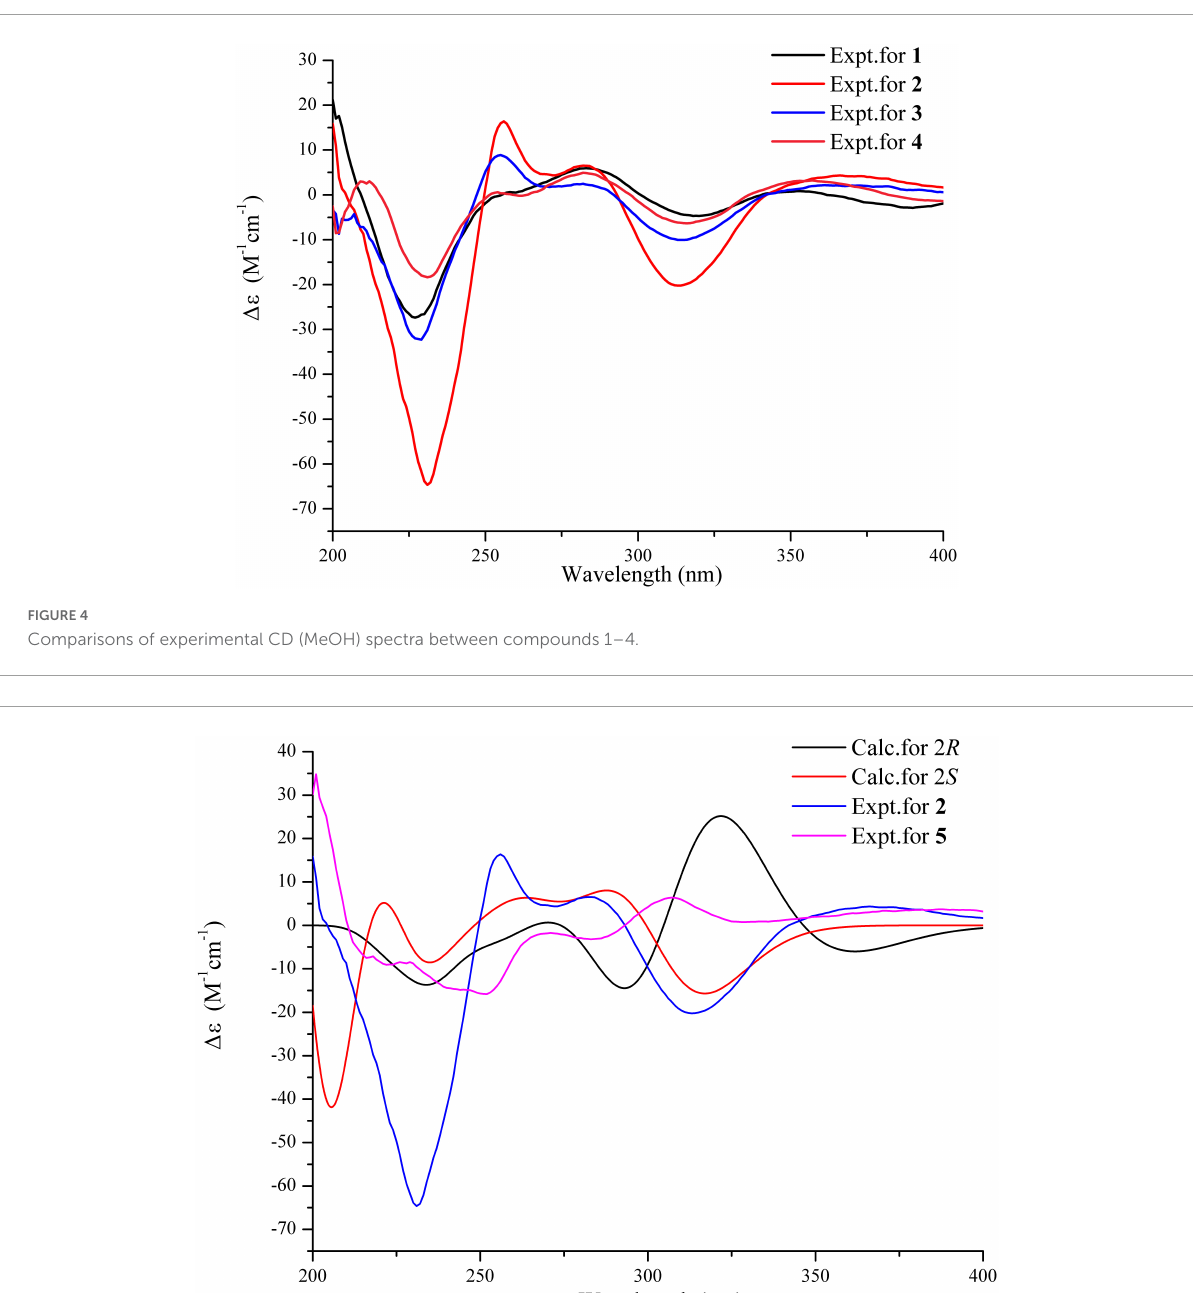
FIGURE5 Experimental CD spectra of compounds 2 and 5 (MeOH) and ECD calculations of 2 R and 2 S